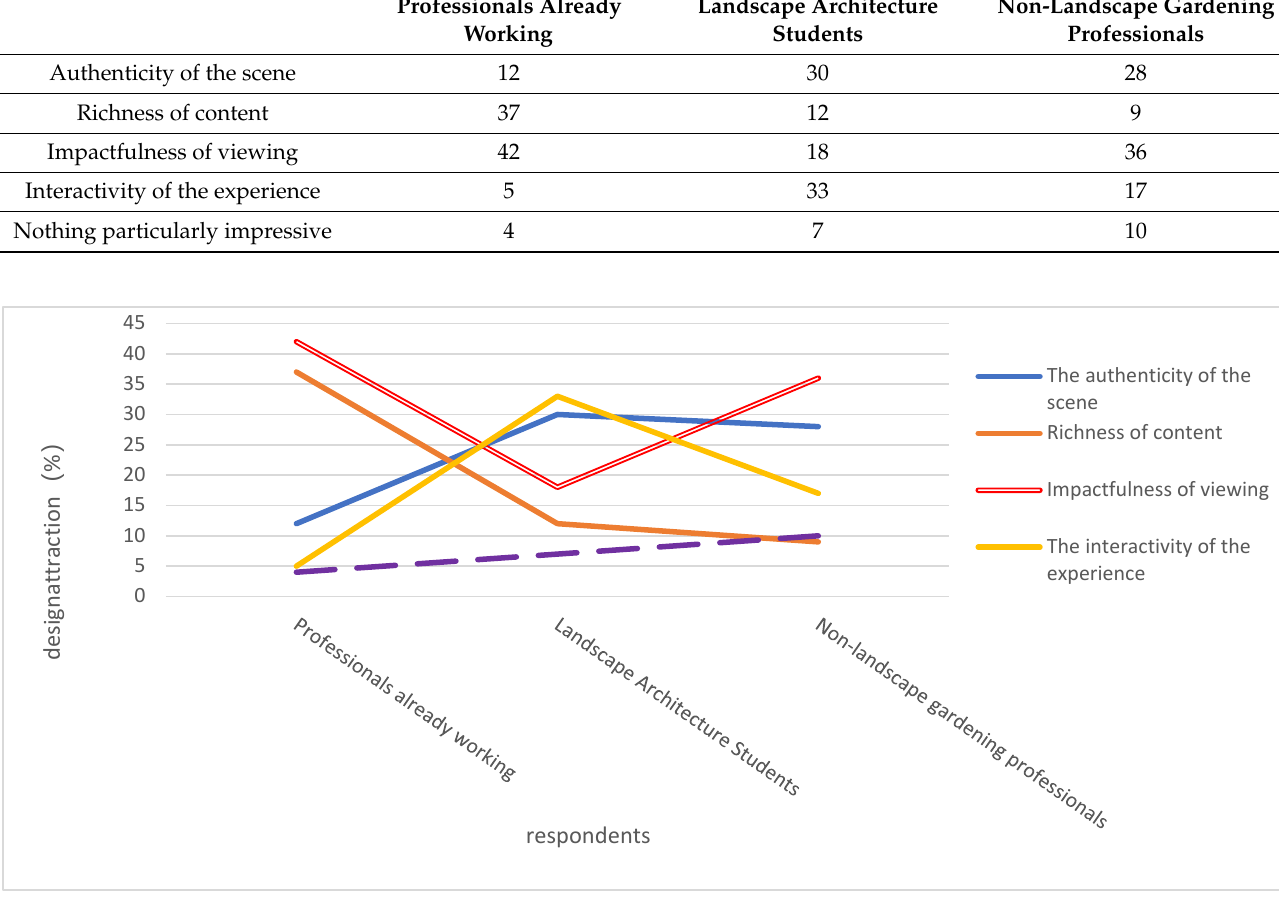
Figure 12. Design attraction points .